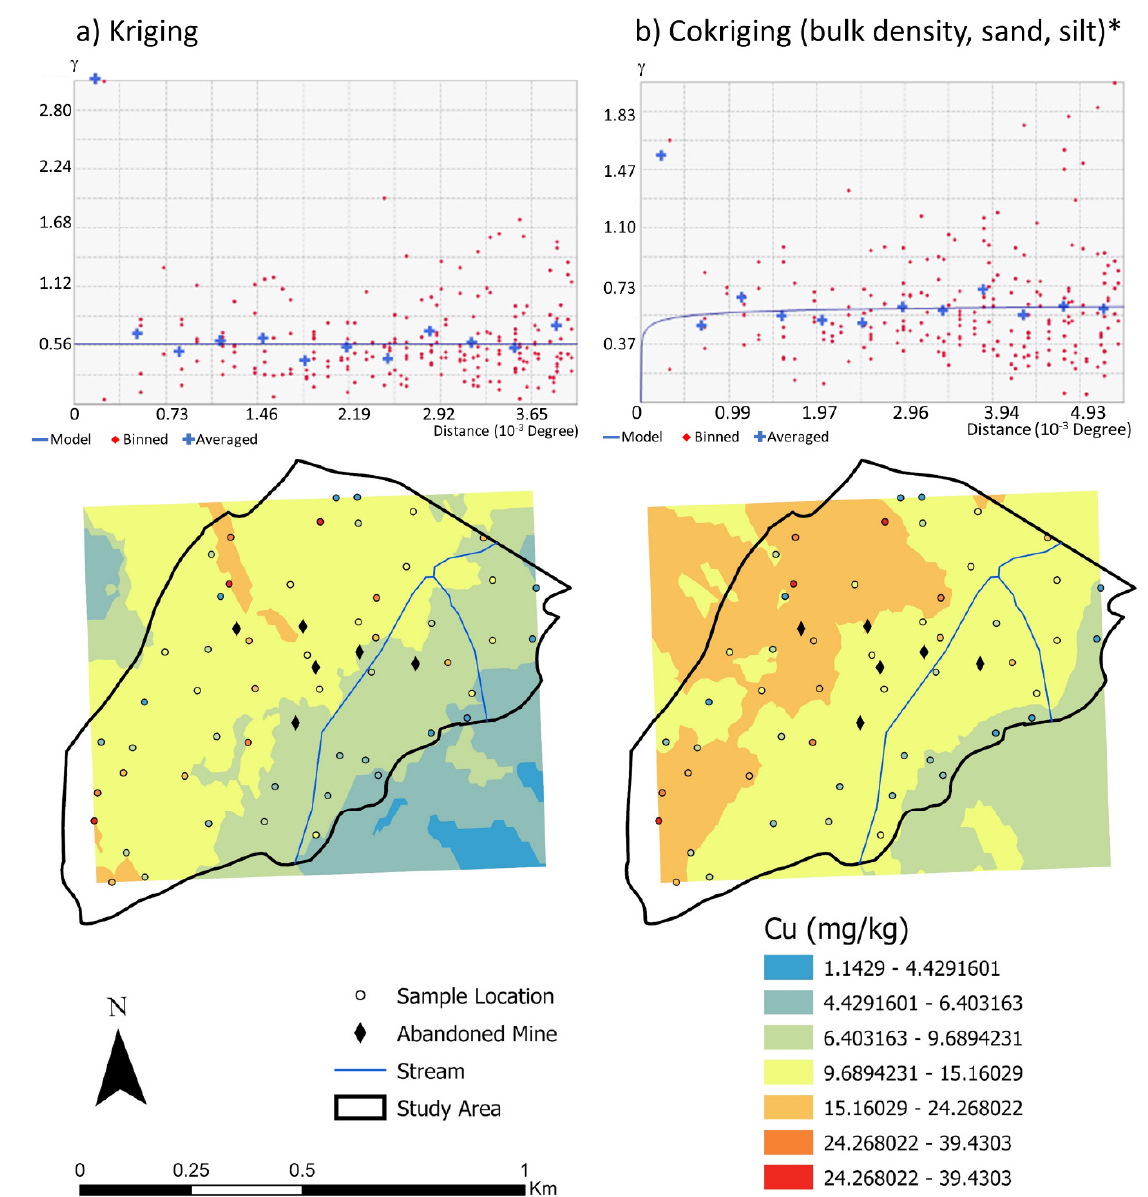
Figure 6. Variograms and interpolated Cu concentration using ordinary kriging ( a ) and cokriging ( b ). Cokriging model, marked with an asterisk, was selected as the superior model.